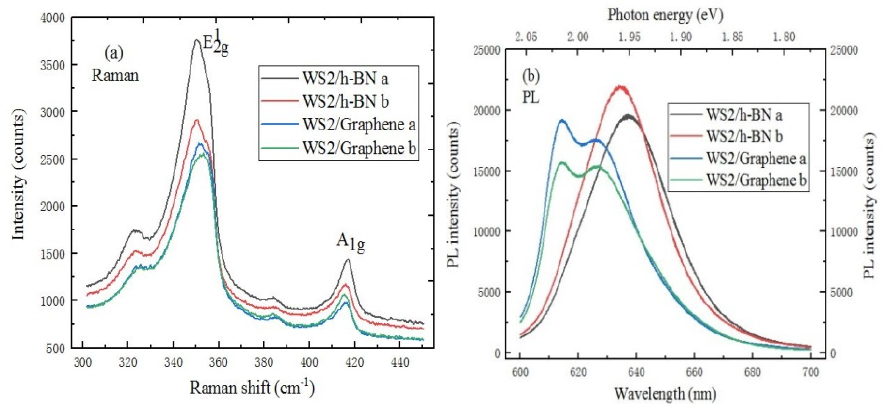
Figure 11. ( a ) Raman spectrum (10 mW, 633 nm), ( b ) PL spectrum (20 mW, 633 nm) comparison of WS 2 on h-BN/SiO 2 /Si or graphene/SiO 2 /Si substrate.